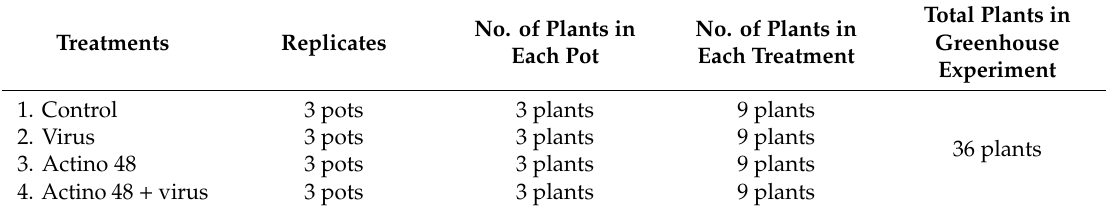
Table 1. Greenhouse experiment